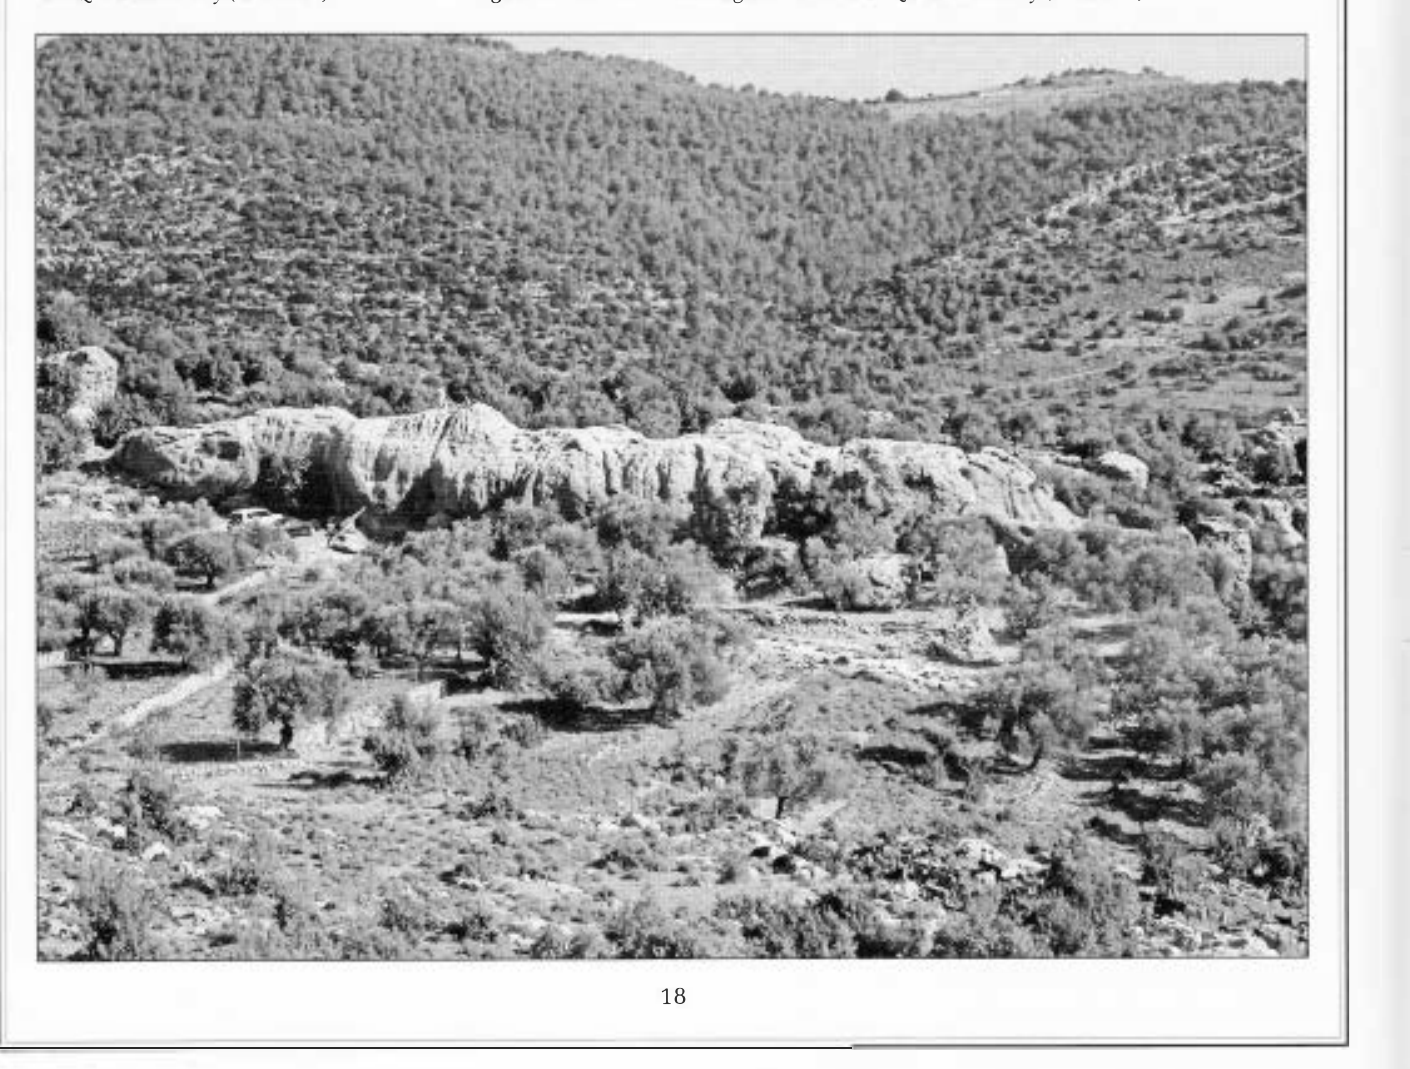
FigureB The Levant region: the locations of Azraq (Jordan}, Sakr,:agozii (Turkey) and the Qadisha Valley (Lebanon). Figure 9 The caves at Moghr el-Ahwal in Qadisha Valley